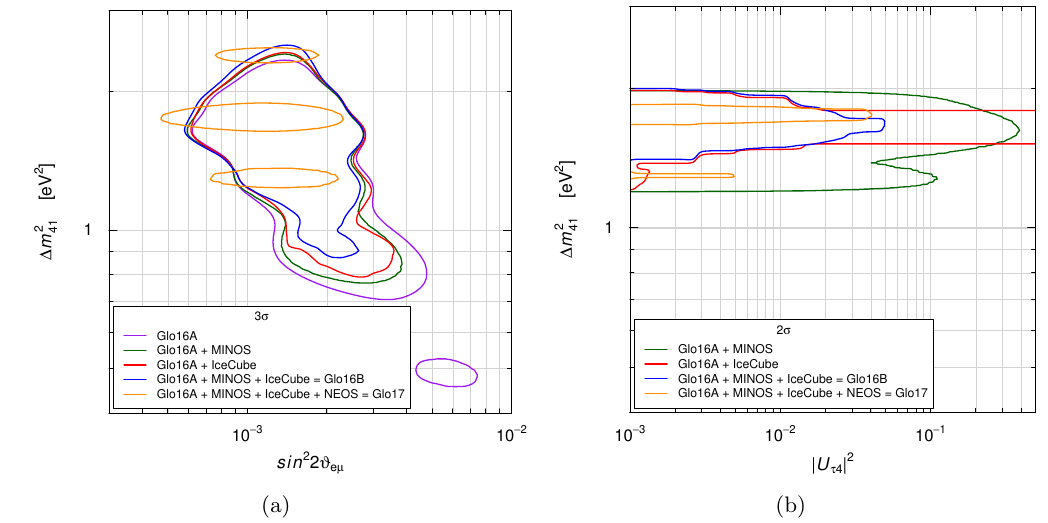
Figure 11 . Comparison of (a) the 3 (cid:27) allowed regions in the sin 2 2 # e(cid:22) {(cid:1) m 2 plane and (b) the 2 (cid:27) 41 allowed regions in the j U (cid:28) 4 j 2 {(cid:1) m 2 plane obtained by adding to the data set of the Glo16A (cid:12)t the 41 MINOS and IceCube data separately and together, and by adding also the NEOS data.